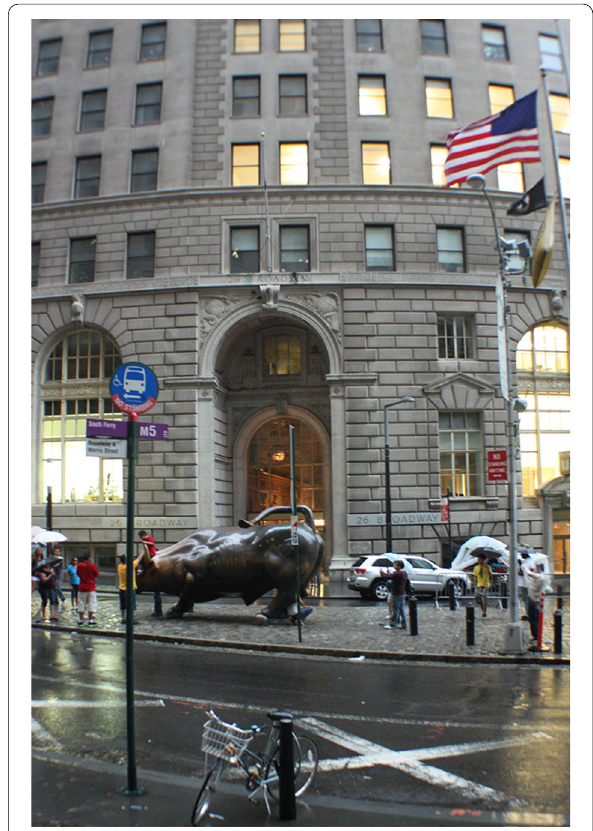
Fig. 8 The Charging Bull symbolizes the stock bull